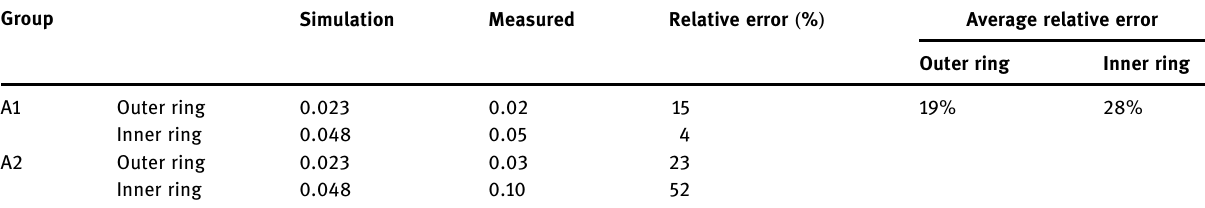
Table 3: The comparison between measured and simulation maximum machining deformation ( unit: mm )